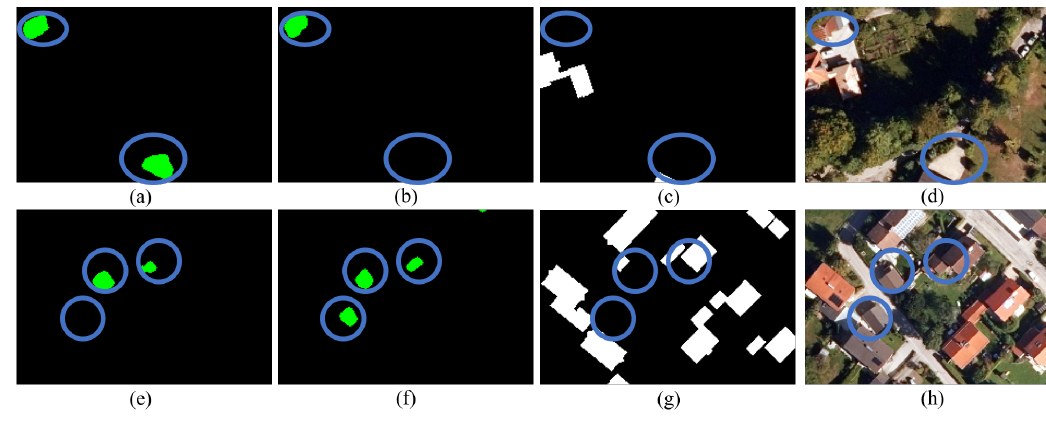
Figure 7. The buildings in Bad Toelz obtained from (a), (e) Trained model 1, (b), (f) Trained model 2, and their corresponding (c), (g) DFK as ground reference as well as (d), (h) TrueDOP.